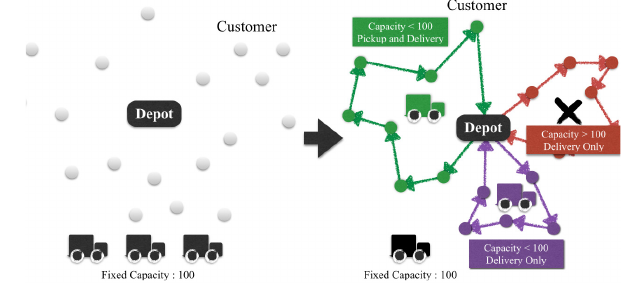
Figure 1. Concept of